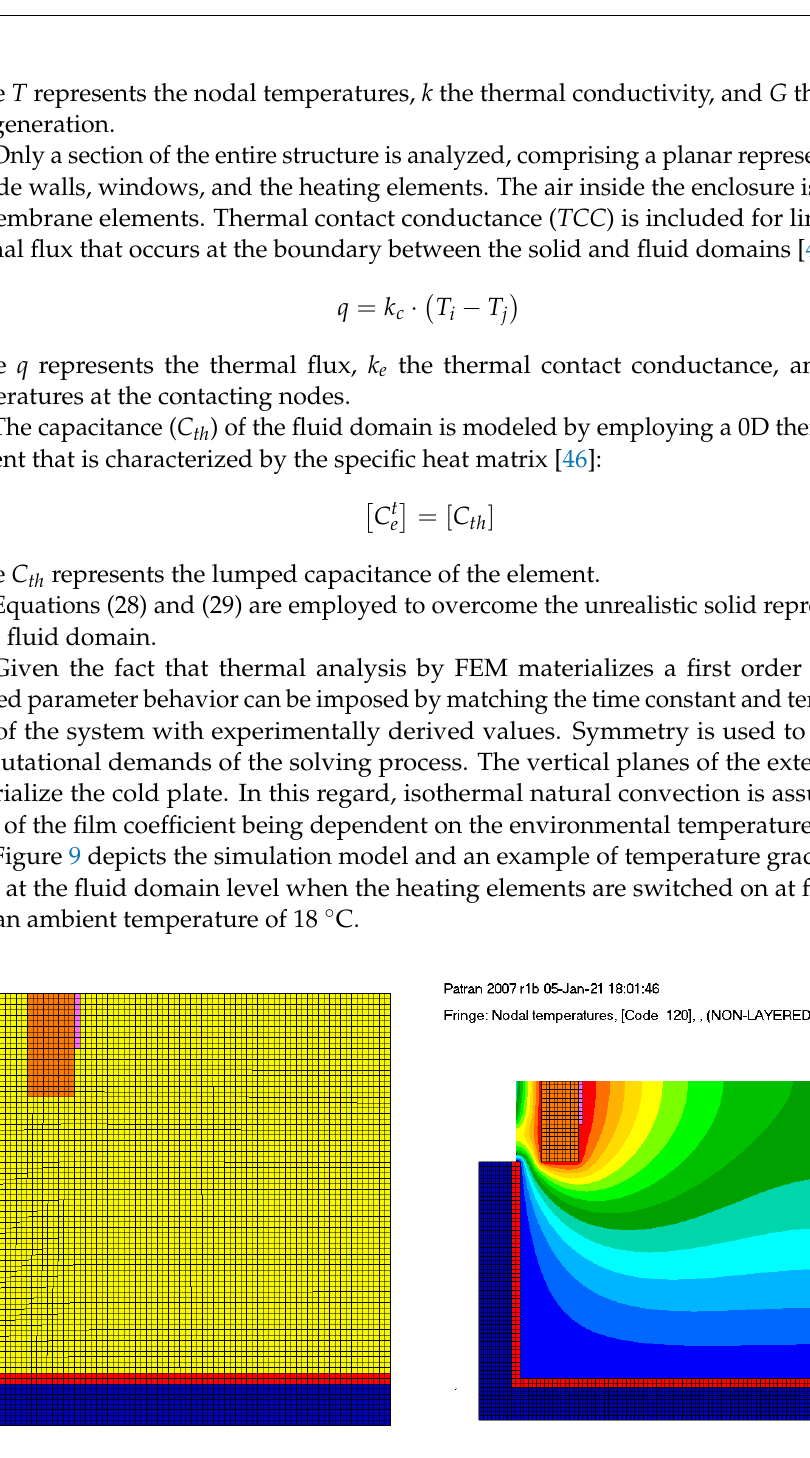
Figure 9. Representation of the 2D heat transfer simulation approach.